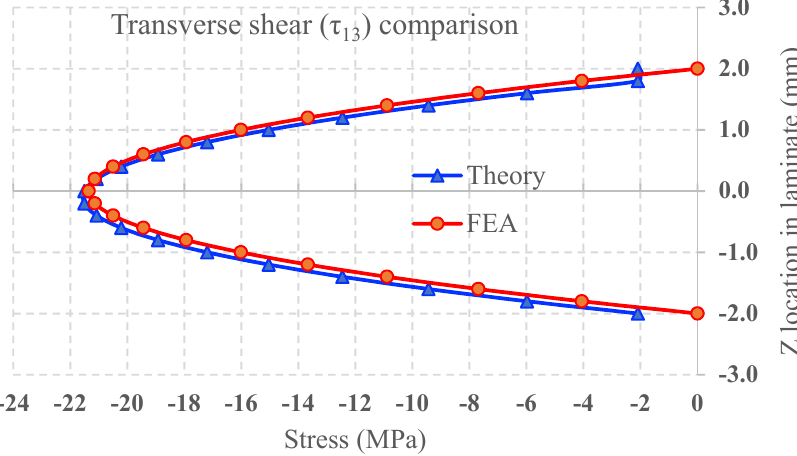
Figure 5. Comparison of FEA-obtained shear to Bernoulli–Euler beam theory.